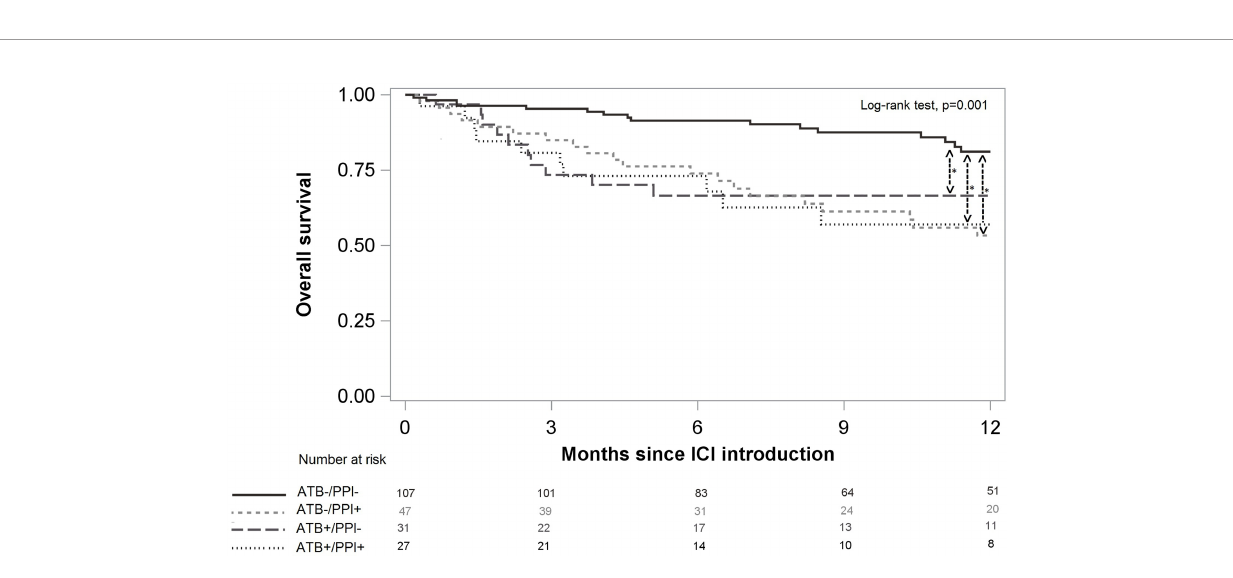
FIGURE 4 | Overall survival according to ATB and/or PPI use. Signi fi cant differences after multivariate analysis are symbolized with a